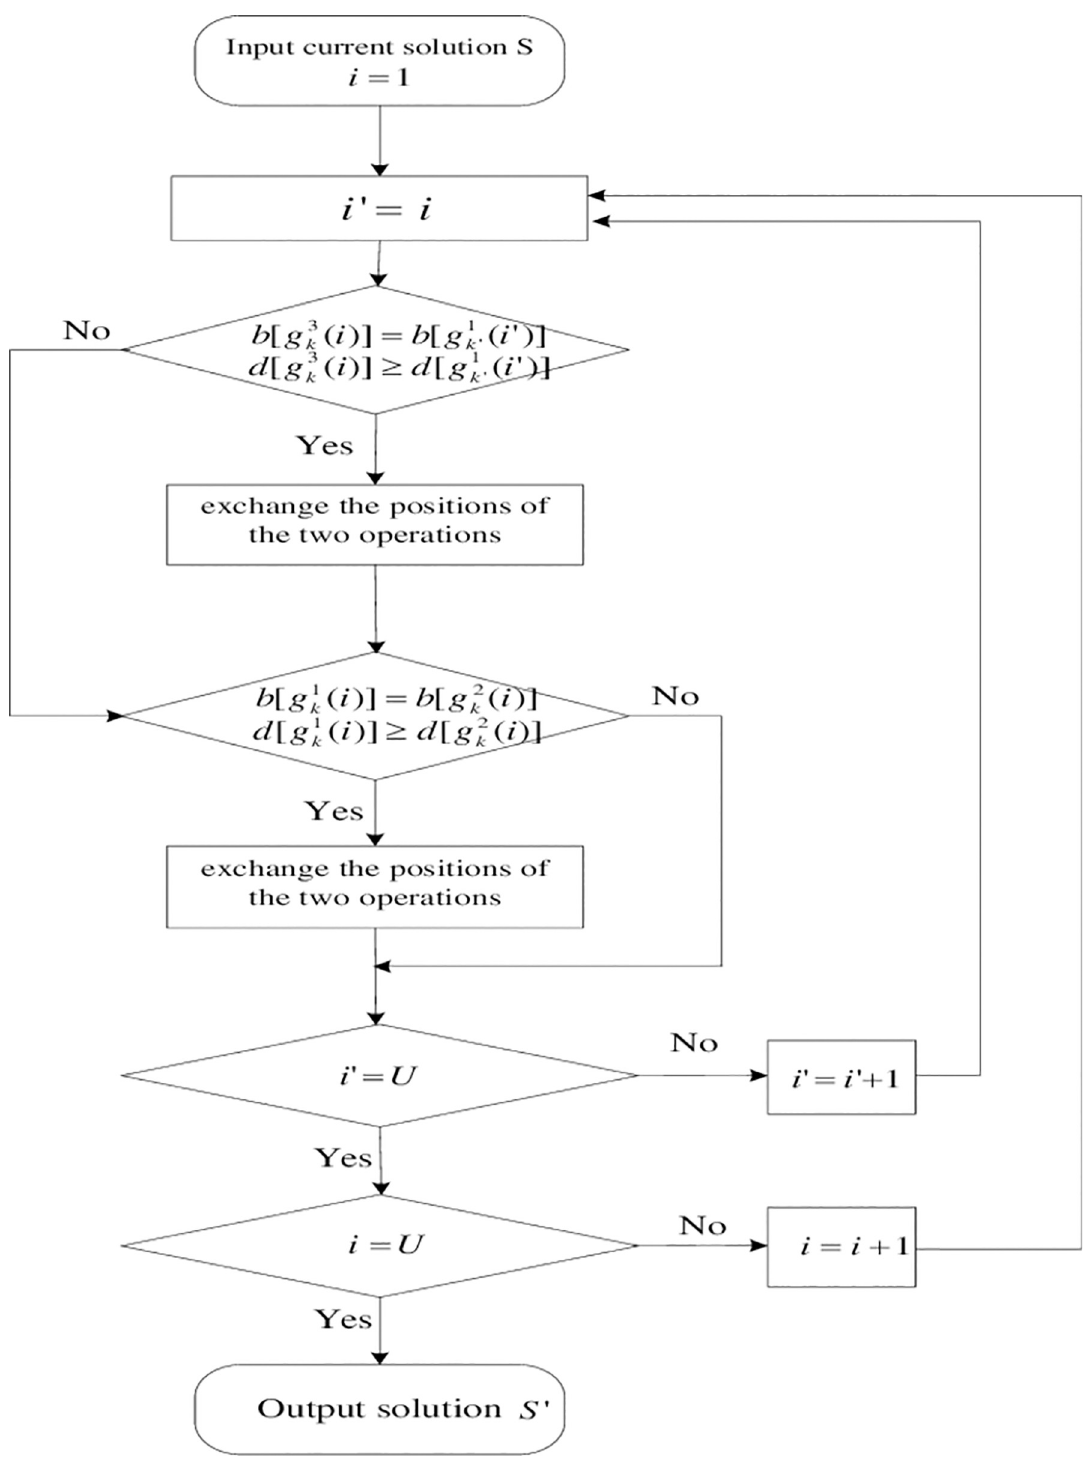
Fig 2. Flow chart of judging and processing reverse of delivering and fetching wagons.